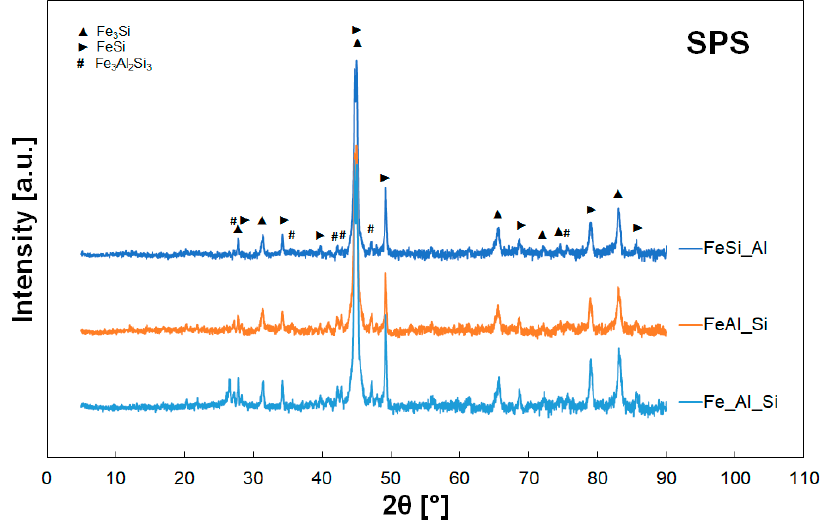
Figure 10. Phase composition of the sintered samples.